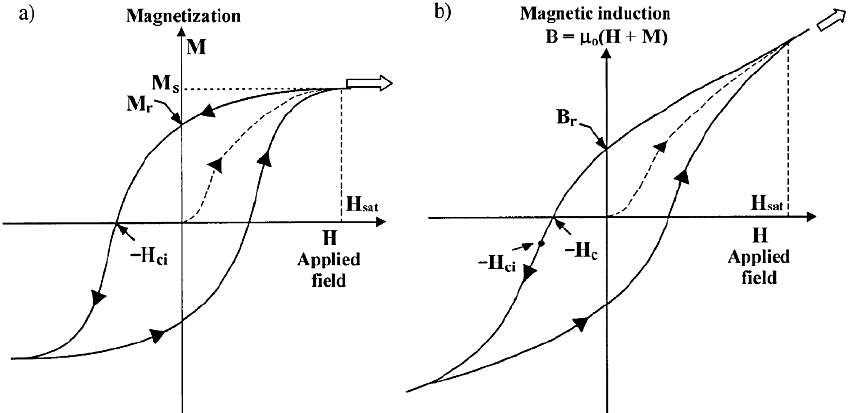
Figure 1. Ferromagnetic material hysteresis curves expressed as M vs. H ( a ) and B vs. H ( b ) curves. Legend: M s is the saturation magnetization, M r is the remnant magnetization at H = 0, H ci is the intrinsic coercivity, B r is the remnant induction (or remanence) at H = 0, and H c is the coercivity. For hard magnets: H ci ≠ H c ; for soft-magnets: H ci ≈ H c . Reprinted with permission from [40], published by Elsevier, 2003.